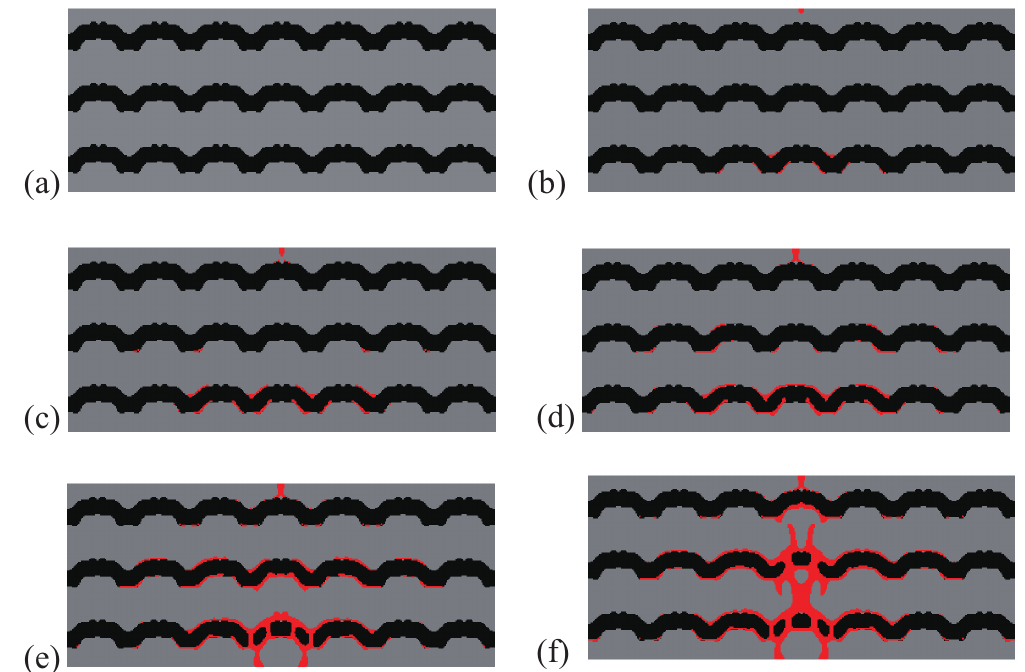
Figure 5. Crack propagation in the periodic composite subjected to three-point bending, optimized design: ( a ) ¯ U = 0 mm; ( b ) ¯ U = 0.17 mm; ( c ) ¯ U = 0.23 mm; ( d ) ¯ U = 0.28 mm; ( e ) ¯ U = 0.32 mm; ( f ) ¯ U = 0.37